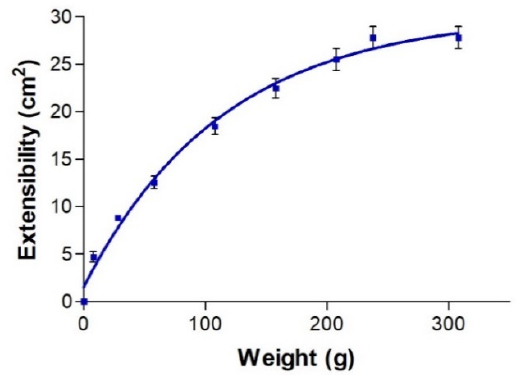
Figure 3. Extensibility profile of AmB+BGEO gel at 25 °C.